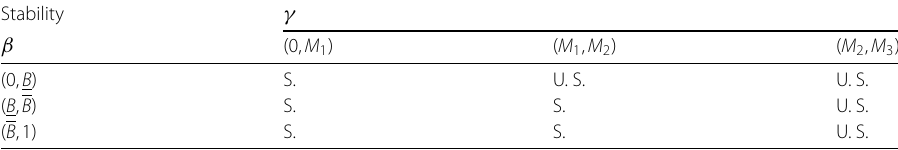
Table 3 The stability properties of the disease-free equilibrium point when e > E